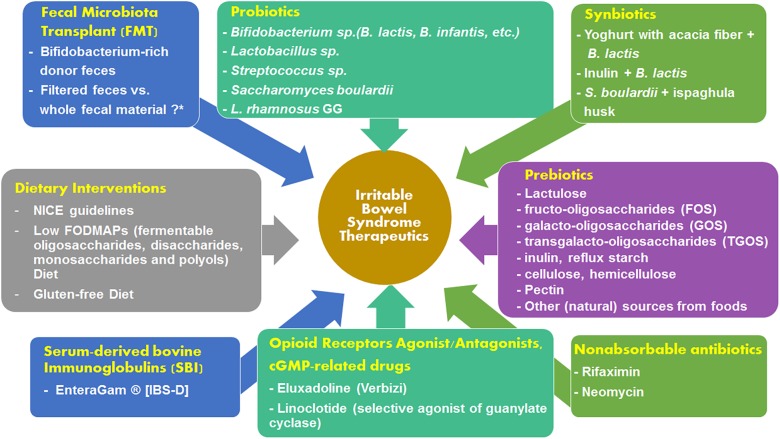
Summary of the available treatment options for mitigating the severity of IBS symptoms.